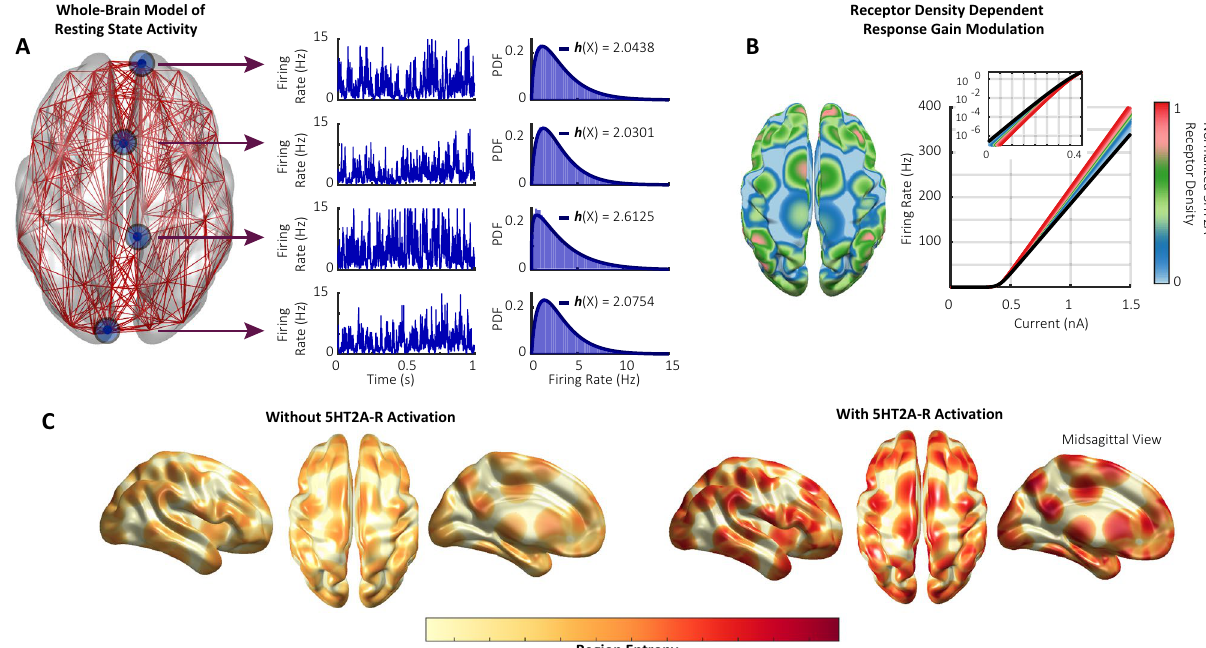
Figure 1. Modelling the effect of 5HT2A-R activation on the whole-brain topographical distribution of entropy. ( A ) Resting state activity is simulated using the dynamic mean-Field (DMF) model, in which each region’s activity is represented by a time series of excitatory firing rates (constrained to 0–15 Hz for visualisation). The probability density function (PDF) and differential entropy ( h (X)) of each region is then estimated, obtaining a topographical distribution of entropy values. ( B ) 5HT2A-R agonism is modelled as a receptor-density- dependent response gain modulation. Black line is the frequency–current (F–I) curve of a population without 5HT2A-R agonism, and coloured curves show the resulting F–I curves of regions with increasing 5HT2A-R agonism. ( C ) 5HT2A-R activation changes the topographical distribution of entropy with respect to resting state activity, which constitutes the main subject of analysis in this